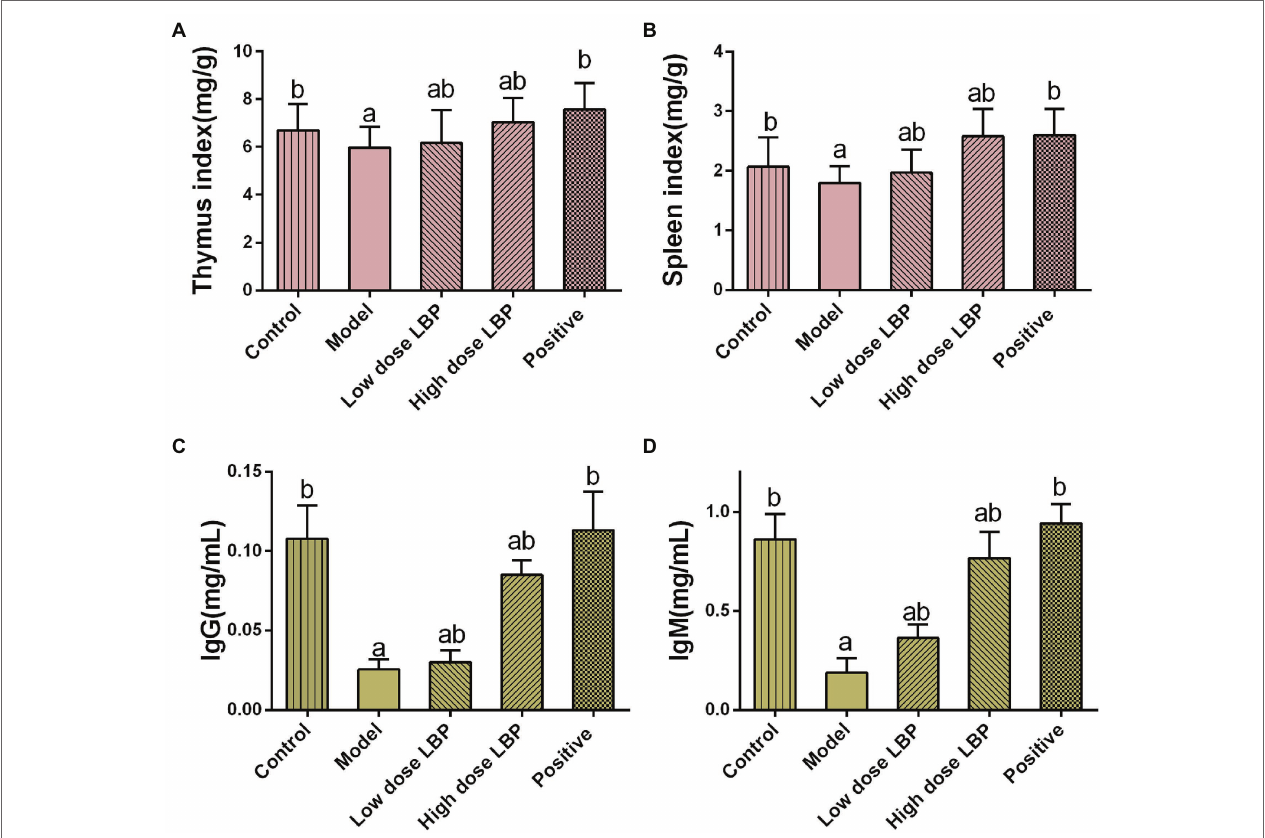
FIGURE 2 | The immunomodulatory effects of LBP in cyclophosphamide (Cy)-treated mice. (A) Spleen index, (B) thymus index, (C) IgG amounts, and (D) IgM amounts. Values are mean ± SD ( n = 8). a p < 0.05 vs. control group; b p < 0.05 vs. model